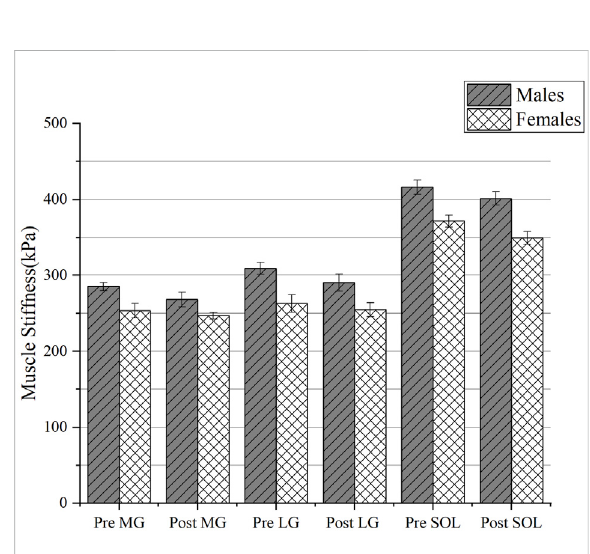
FIGURE 7 The change of muscle stiffness of hamstring muscles between genders. Abbreviations: BF, biceps femoris muscle; ST, semitendinosus muscle; Pre, pre-stretching; Post, post-